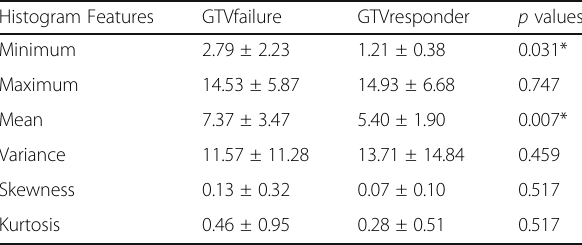
Table 2 Mean histogram feature comparison between GTVfailure and GTVresponder, with associated Wilcoxon